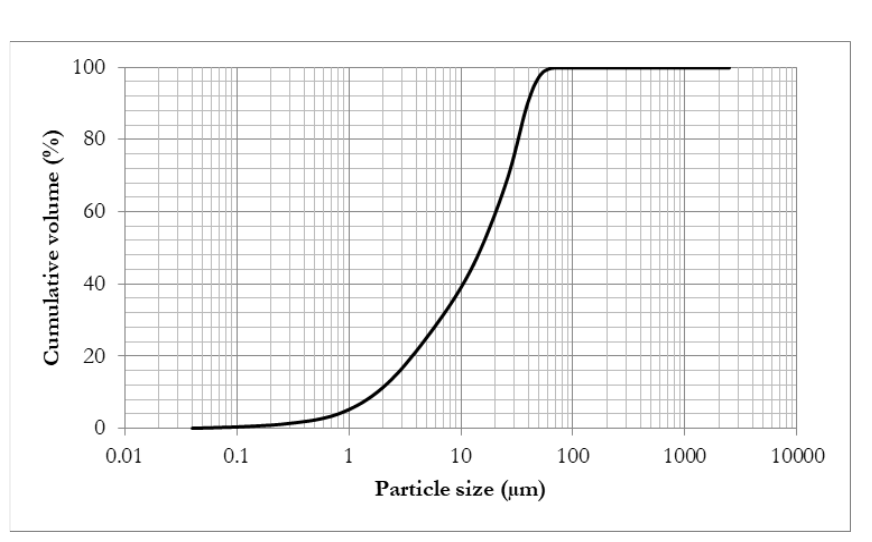
Figure 2. Granulometric curve of the